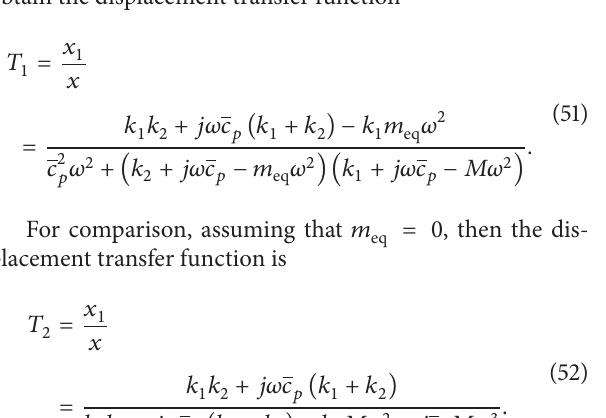
̸= 0 . (b) Amplitude-frequency characteristic when 𝑚 eq